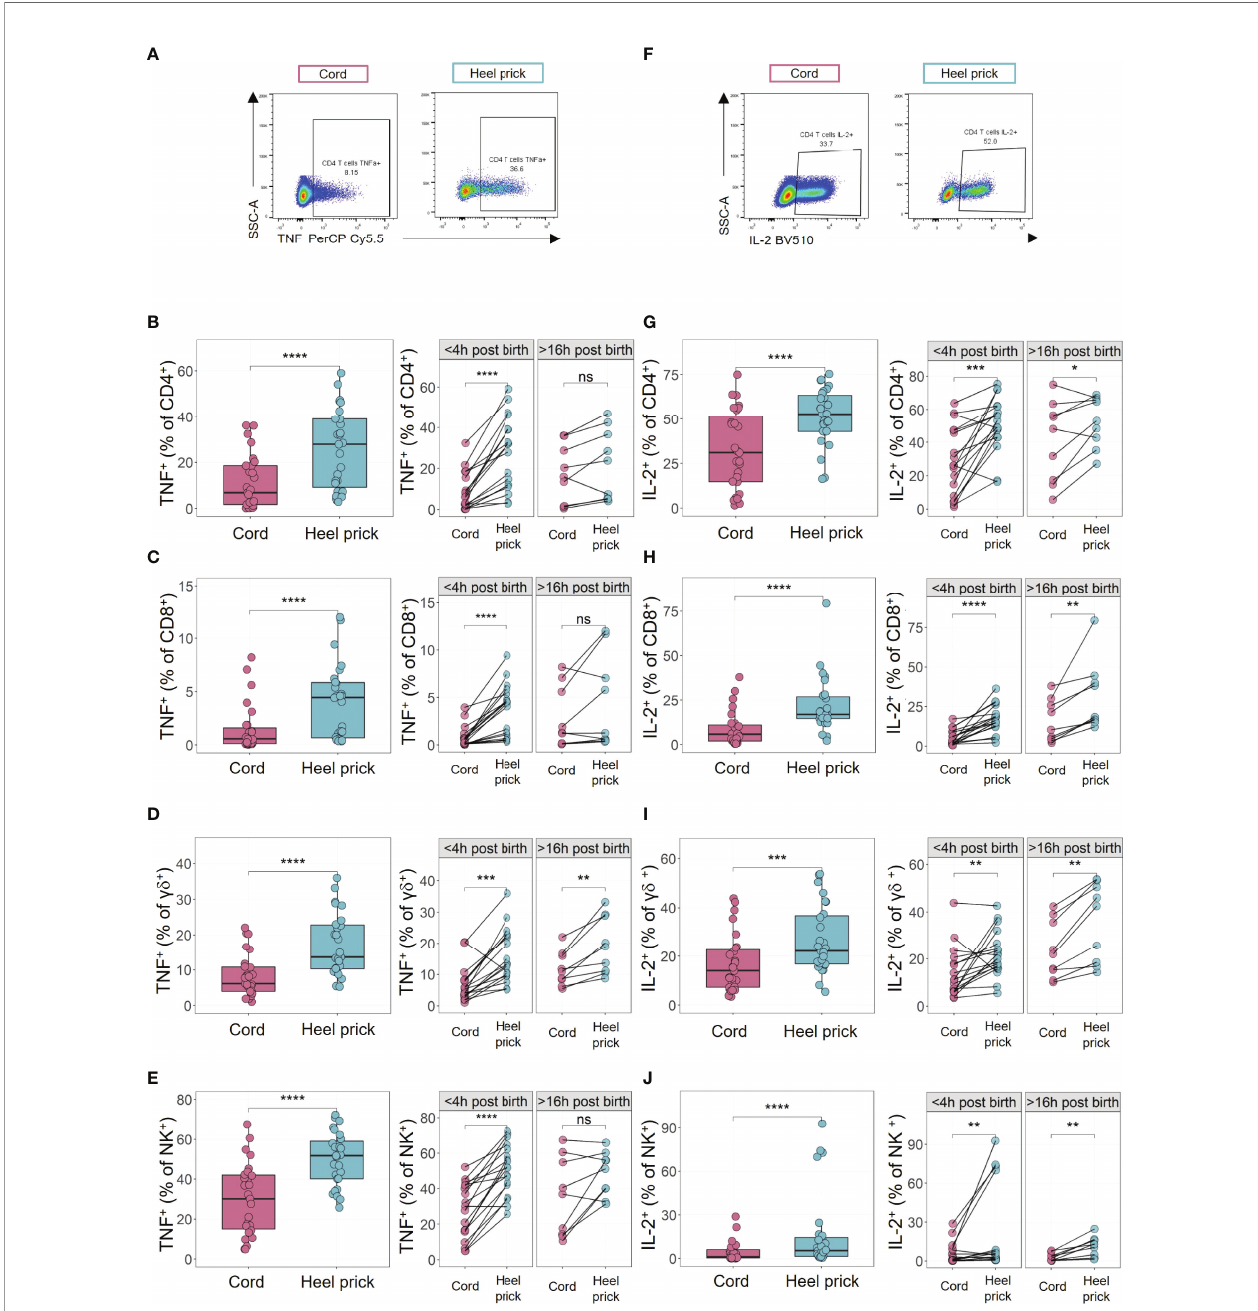
FIGURE 4 | Elevated percentages of cytokine-expressing immune cells observed immediately post birth. Cytokine production was measured by multiparametric fl ow cytometry in mononuclear cells isolated from cord blood or paired heel prick samples in response to polyclonal stimulation [PMA (10 ng/ml), ionomycin (1 m g/ml), brefeldin A (20 ng/ml) and monensin solution (2 m M) at 37 °C for 4 h]. (A) Representative fl ow plots of TNF in CD4 + T cells from cord and heel prick samples. (B – E) The percentage of TNF expressing cells in CD4 + (B) , CD8 + (C) and gd + (D) and NK (E) cells from cord blood (n=28) compared to heel prick samples collected <4 h (n=18) or >16 h post birth (n=10). (F) Representative fl ow plots of IL-2 in CD4 + T cells from cord and heel prick samples. (G – J) The percentage of IL-2 expressing cells in CD4 + (G) , CD8 + (H) and gd + (I) and Natural Killer (NK) (J) cells from cord blood (n=28) compared to heel prick samples collected <4 h (n=18) or >16 h post birth (n=10). Box and whisker plots follow standard Tukey representations and indicate the median (central line), the interquartile range (upper line = 75 th percentile, lower line = 25 th percentile), and the whiskers represent 1.5 x 75 th /25 th percentile. P values (***p<0.001, ****p<0.0001) for all paired data between cord and heel prick samples were assessed using two-sided paired Wilcoxon tests. *p<0.05, **p<0.01, ns, non-signi fi